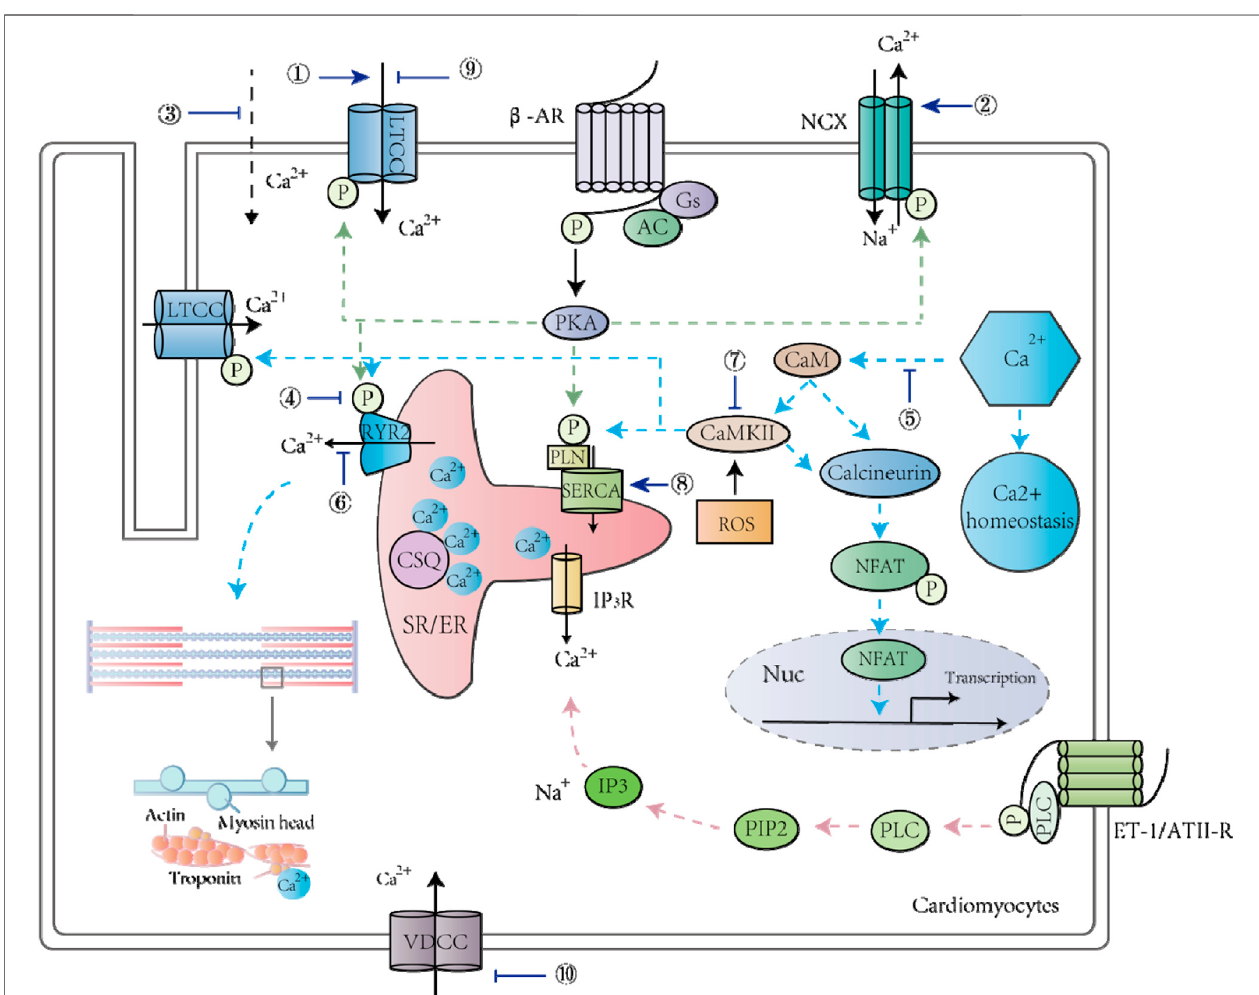
FIGURE 1 | TCM and its active ingredients treat CVDs by regulating calcium signaling pathways in cardiomyocytes. ① Matrine; ② Matrine; ③ Changrolin, Paeoni fl orin monomer, Dehydroevodiamine alkaloid; ④ Stachydrine; ⑤ Scutellarin, Astragali Radix; ⑥ Senkyunolide A, Smilax glabra fl avonoids, Baicalein; ⑦ Astragalus polysaccharide; ⑧ Baicalein; ⑨ 6-Gin; Astragaloside IV; Wenxin Keli; Qiliqiangxin; Total fl avones from AS; ⑩ Senkyunolide A; Ligustrazine.